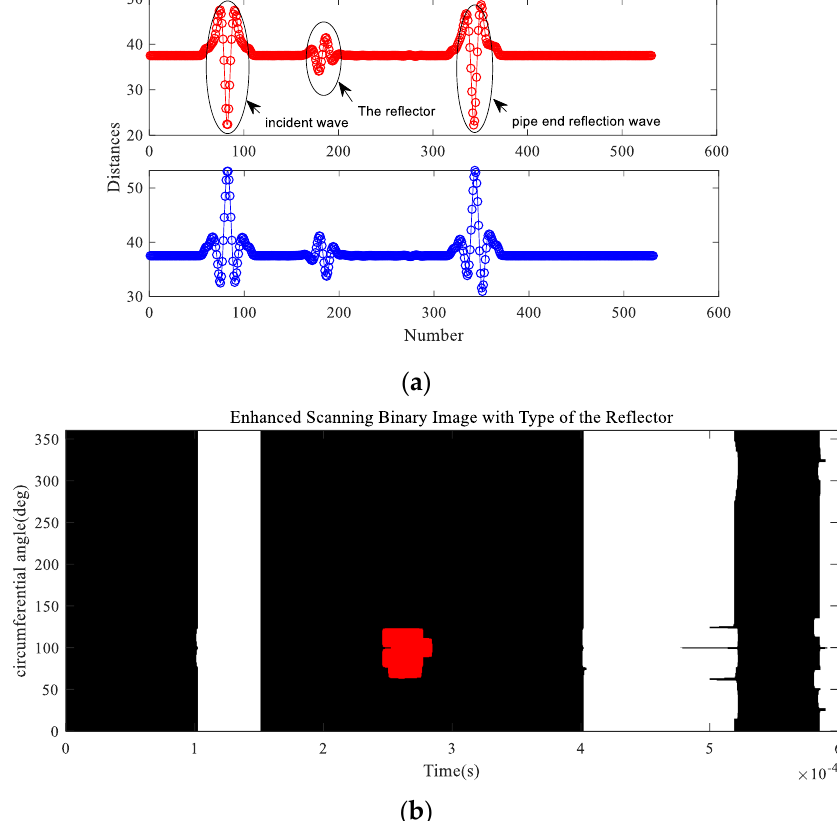
Figure 13. Analysis results based on the proposed method; ( a ) distance curves Ψ 1 ( Up ) and Ψ 2 ( Down ); ( b ) updated judgment results to the enhanced 2D scanned binary image with different colours.